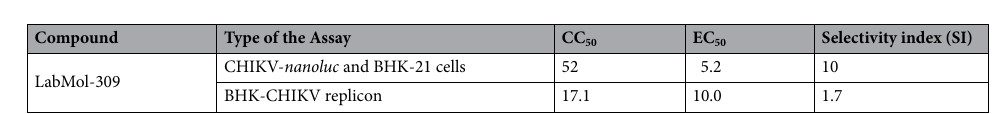
Figure 6. Antiviral activity of LabMol-309. The EC 50 ( A ) and CC 50 ( B ) curves from replicon-based assays are shown. CHIKV replicon cells were incubated with the compound at twofold serial dilutions (from 20 µM to 0.03 µM for EC 50 and from 100 to 0.3 µM for CC 50 ) for 48 h, and Gluc activity/cell viability were measured from cells’ supernatant. For the CHIKV- nanoluc replication assay evaluation of EC 50 and CC 50 ( C ), BHK-21 cells were treated with concentrations of LabMol-309 ranging from 0.78 to 100 µM, in the presence or absence of CHIKV- nanoluc for 16 h, and viral replication was quantified by measuring the nanoluciferase activity (indicated by ● ) and cellular viability was measured using an MTT assay (indicated by ▄ ). Representative results from two independent experiments performed in duplicates. Error bars represent the standard deviations. Figures and statistical analysis were performed using GraphPad Prism 8.